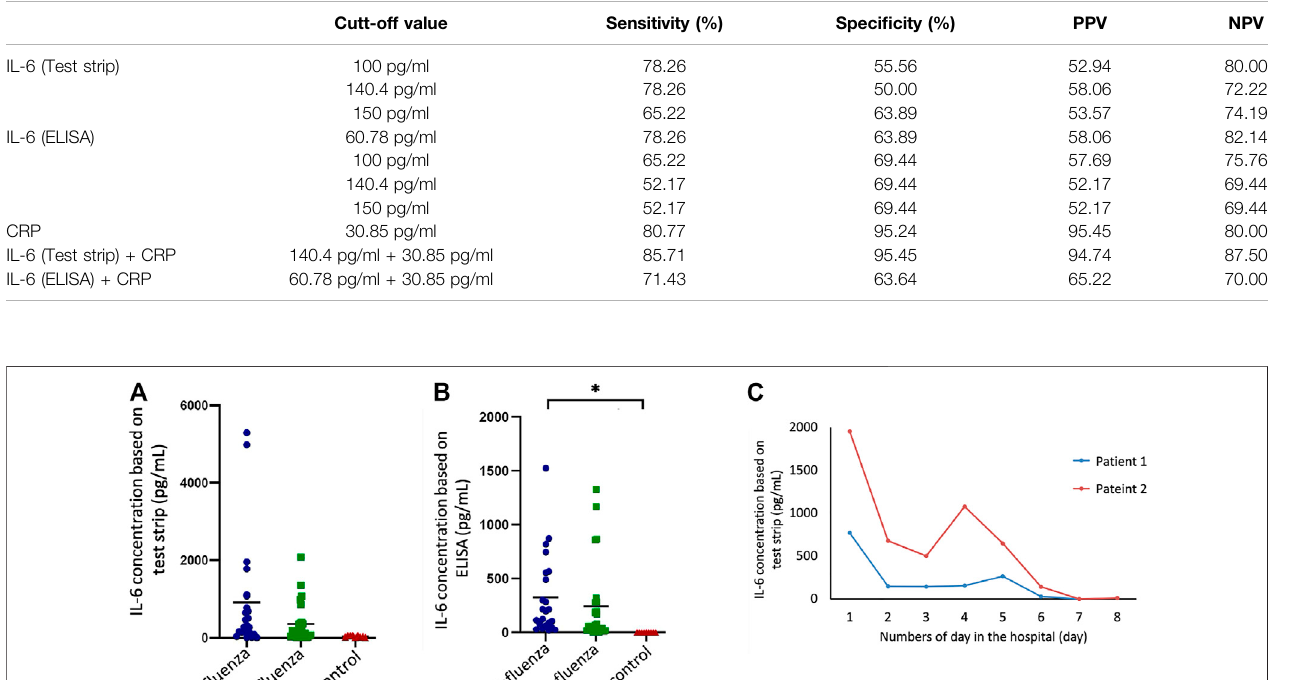
TABLE 1 | Charecteristics of tests based on different cutt-off